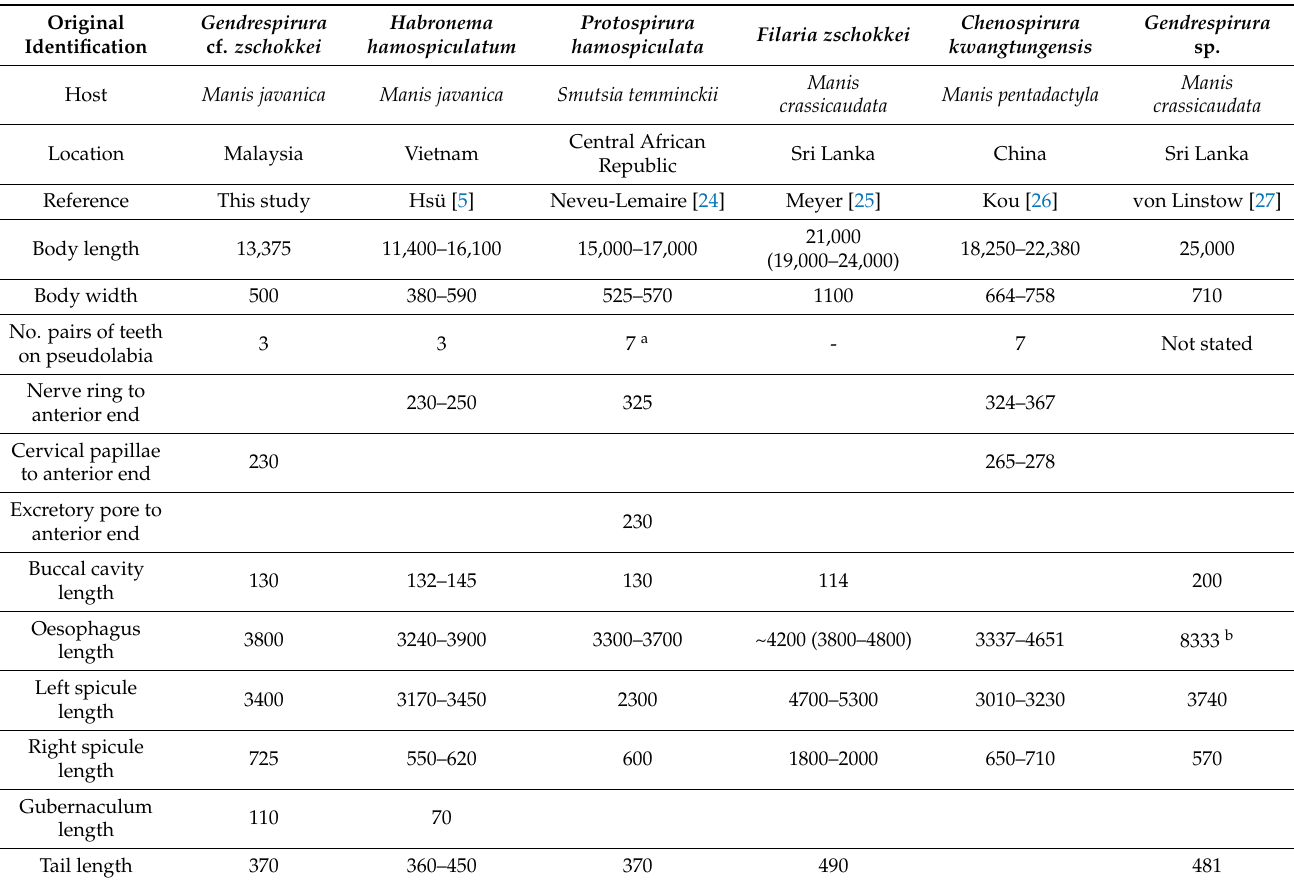
Table 3. Measurements of male Gendrespirura cf. zschokkei collected from Manis javanica in this study compared to previous reports of specimens collected from various pangolins. Species names listed by their original described name; currently all species are considered within Gendrespirura . Measurements are presented in